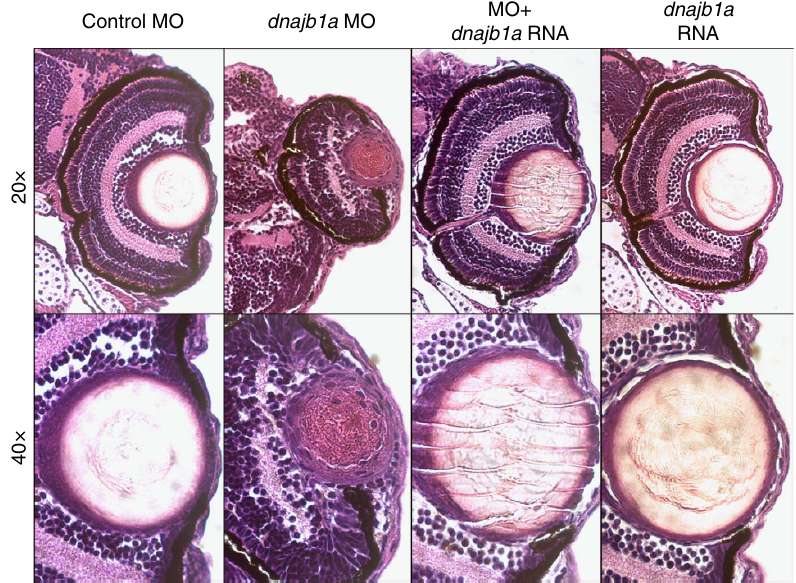
Figure 5 | Histological evaluation of the developmental defects in the anterior segment of dnajb1a morphant eyes. Zebrafish embryos injected with the dnajb1a sbMO (5ng), or the morpholino plus dnajb1a mRNA (150pg) or dnajb1a mRNA. Embryos were fixed 4 days post fertilization in 4% paraformaldehyde and embedded in paraffin. Sections (5 m m) were stained with haematoxylin and eosin and visualized under a microscope for histological